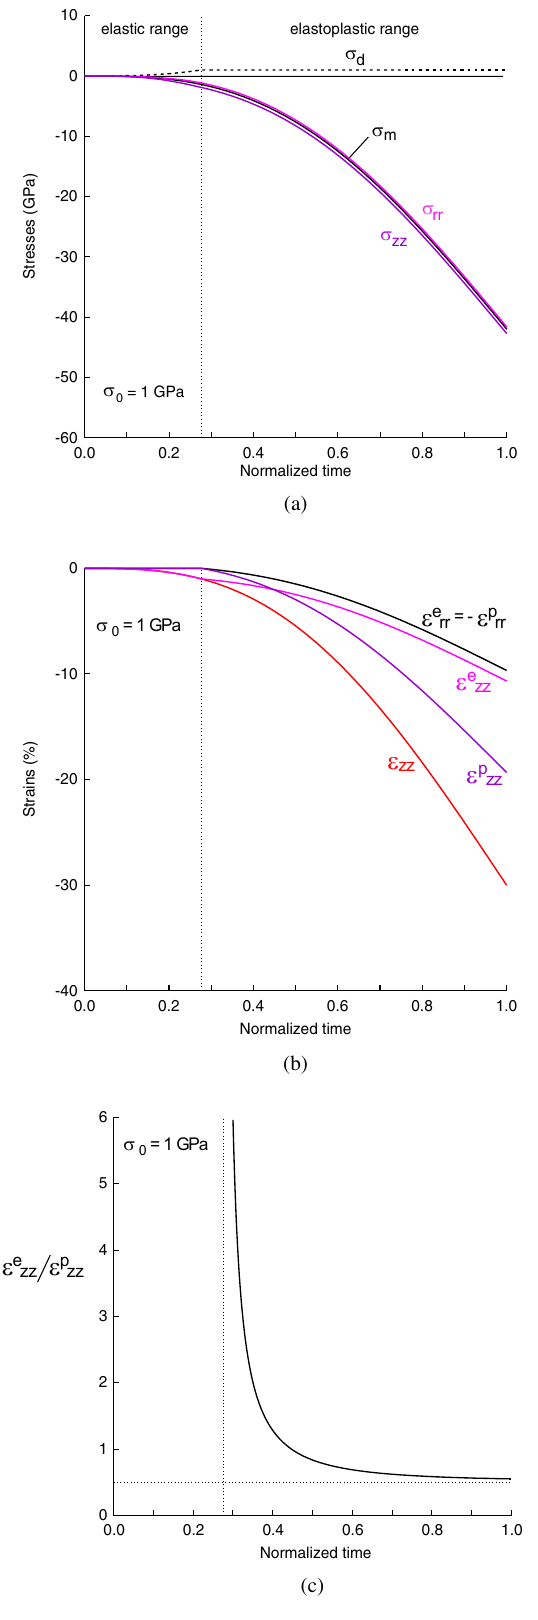
Fig. 2. Time dependence of the stresses (a), the strains (b) and the axial strain ratio (c) for an elastic-perfectly plastic material (see parameters in text).